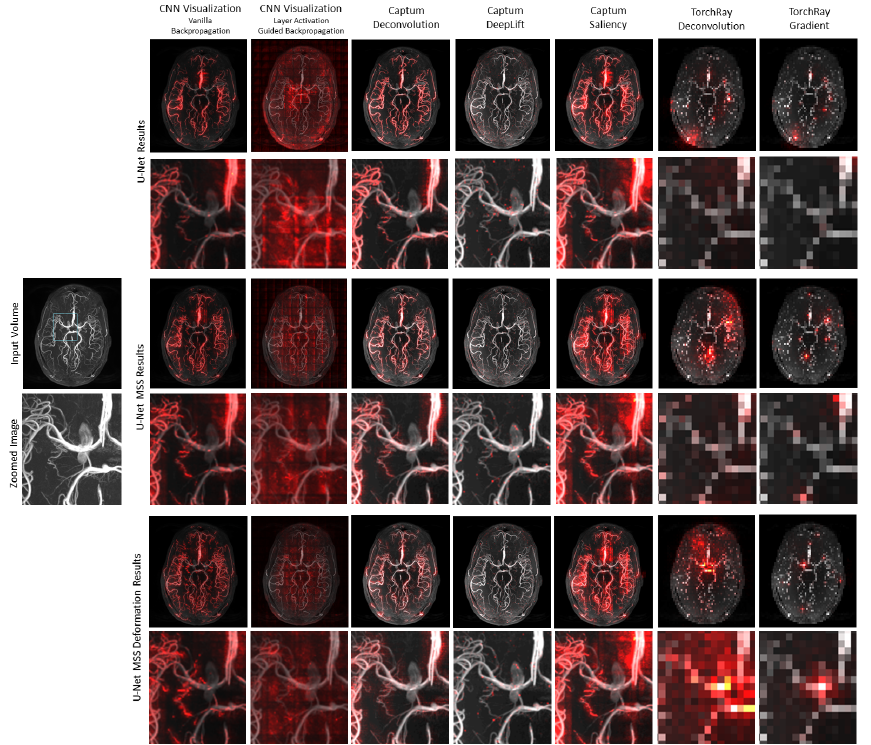
Figure 5. Example of interpretability techniques compared across three models: U-Net, U-Net MSS, and U-Net MSS with deformation, along with its corresponding zoomed image. The higher the intensity of red, the higher the concentration of the focus of the network. Looking at the regions where the network did not focus, it can be understood which parts of the segmentation prediction might be